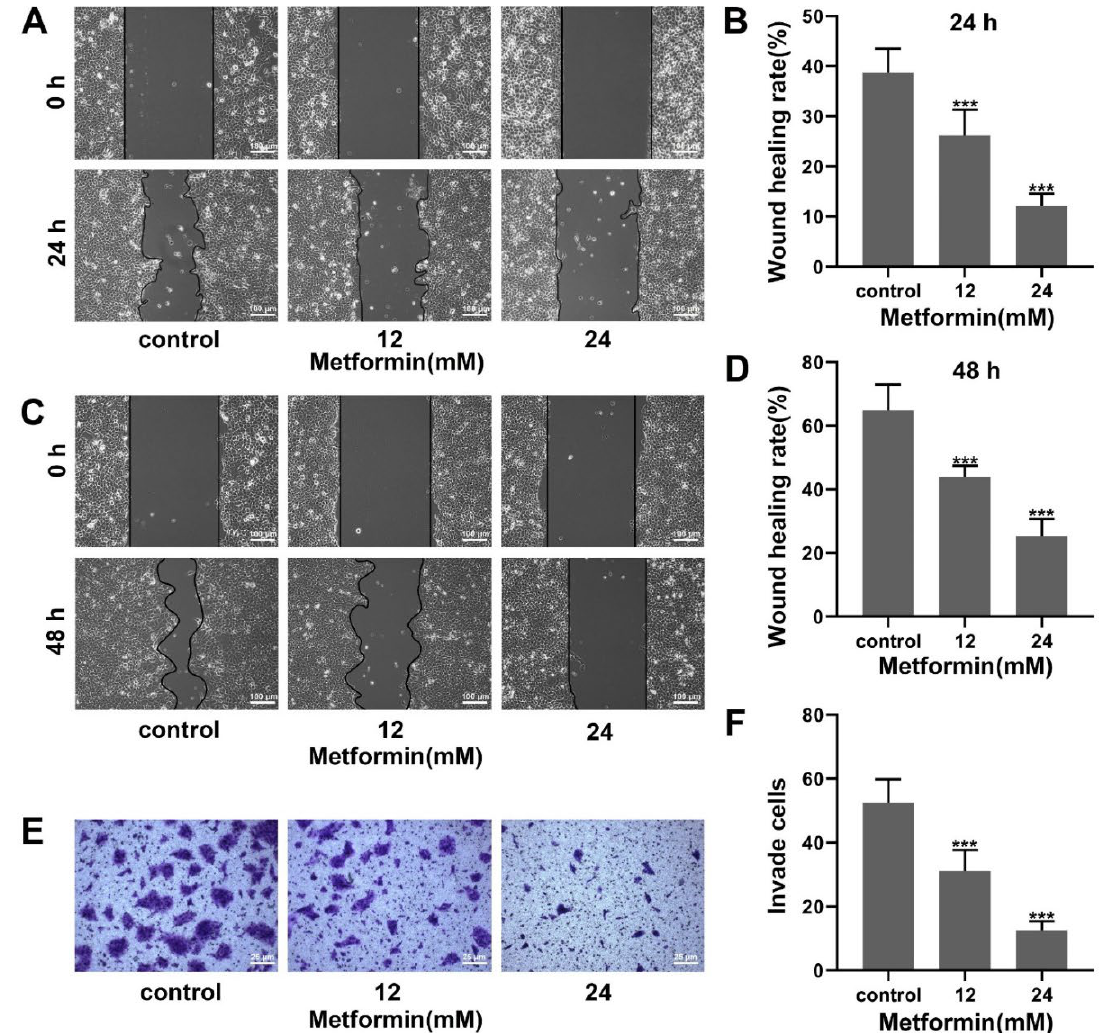
Figure 2. Metformin inhibited migration and invasion in OSCC cells. ( A – D ) The wound-scratch assay was carried out to detect the migrative ability of CAL27 cells treated with metformin for 24 h and 48 h. The wound healing rate = (scratch area at 24 h and 48 h-scratch area at 0 h/scratch area at 0 h) × 100%. The magnification = 100×, scale bars = 100 μm . ( E,F ) A transwell assay for the invasion was carried out to detect the invasive ability of CAL27 cells treated with metformin for 48 h. The magnification = 400×, scale bars = 25 μm . The data are shown in the bar graph as mean ± SD, *** p ≤ 0.001 versus the control group.